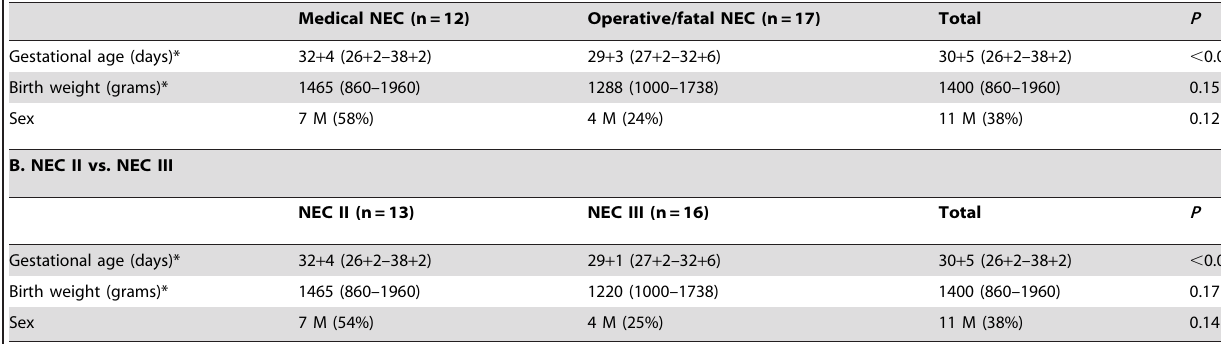
Table 2. Baseline characteristics.